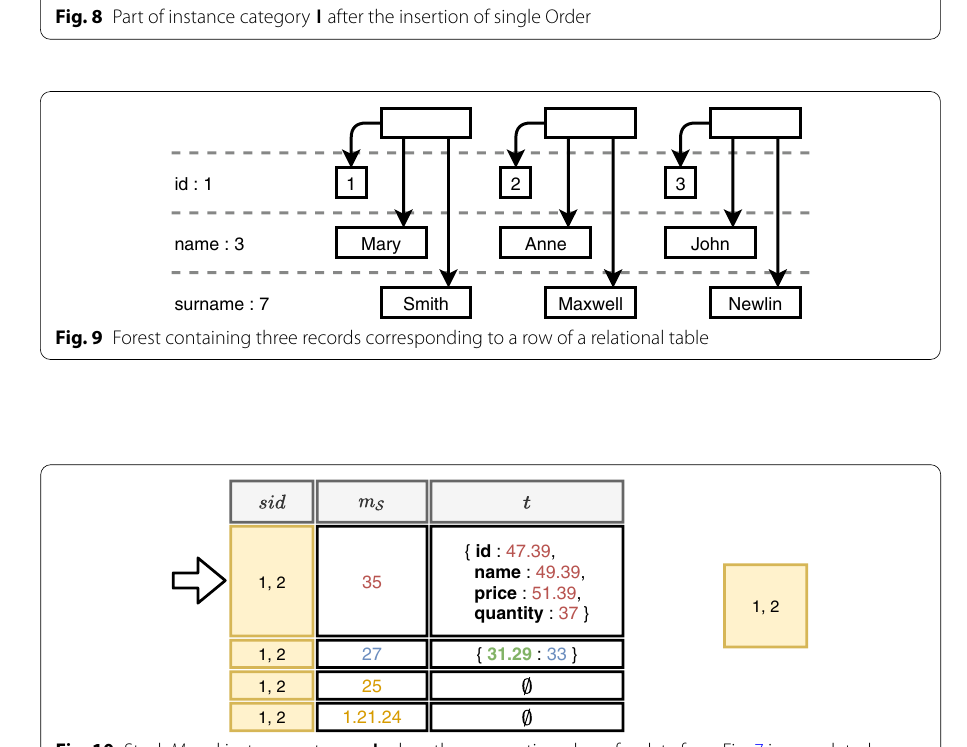
Fig. 8 Part of instance category I after the insertion of single Order